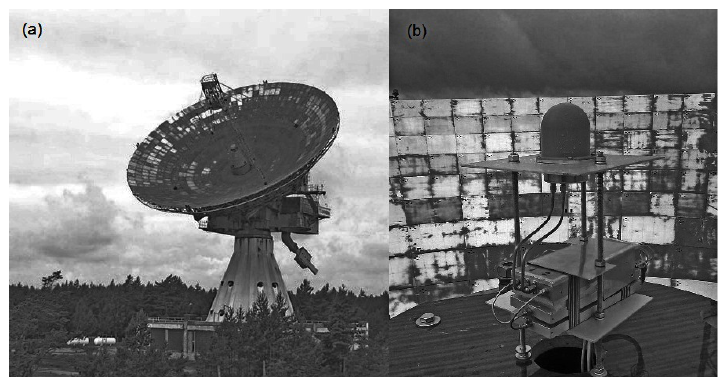
Fig. 1. Left panel: the VIRAC radio telescope RT-32. Right panel: the wide-band feed and UHF part of the spectral polarimeter installed in the secondary focus of the